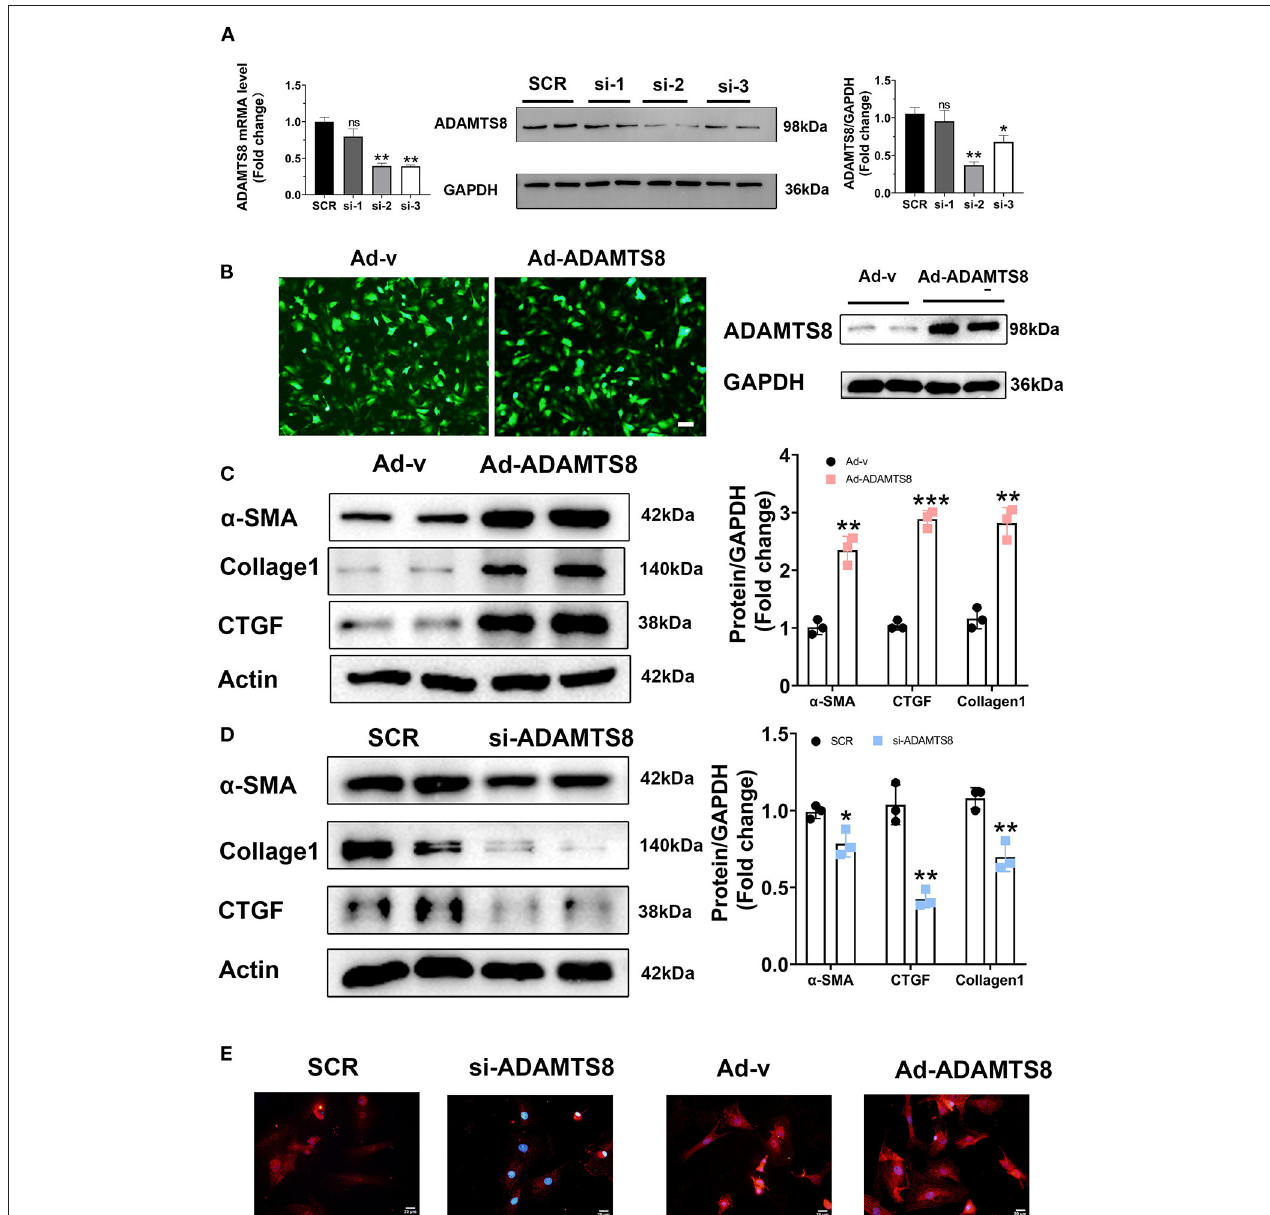
FIGURE 4 | ADAMTS8 promoted myofibroblast formation in vitro . (A) Knockdown efficiency of three different interference sequences of ADAMTS8 detected by qPCR and western blotting. (B) The overexpression efficiency of ADAMTS8 verified by fluorescence and Western blotting. (C,D) α -SMA, Collagen I, and CTGF levels in cultured cardiac fibroblasts infected with ADAMTS8-overexpressing adenovirus or si-ADAMTS8 detected via western blotting. (E) Immunofluorescence for the expression of α -SMA (red) and nuclei (DAPI: blue) (scale bar = 20 µ m). Data were presented as mean ± SEM. * P < 0.05, ** P < 0.01, *** P < 0.001, and NS indicates no significance vs. Ctrl or between the two indicated